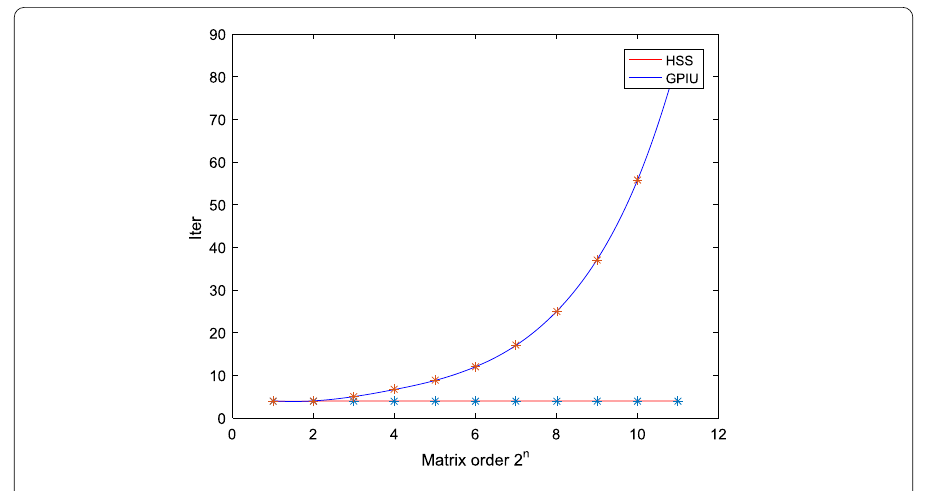
Figure 1 The convergence rate of GPIU and HSS